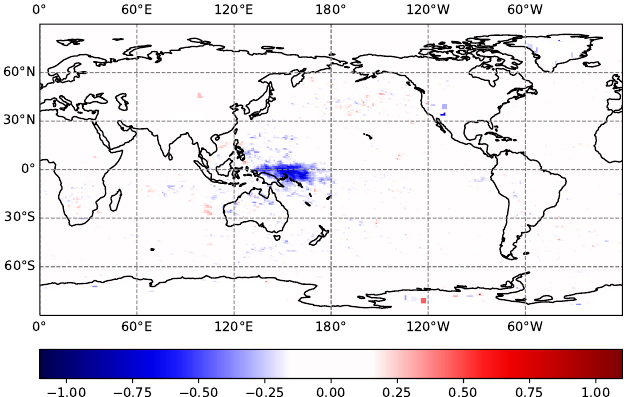
Figure 9. Zonal plot of wind speed bias ( a , b ) and RMSVD ( c , d ) of GK2A IR winds ( a , c ) in GK2AHE experiment and H-8 IR winds ( b , d ) in CNTL experiment.